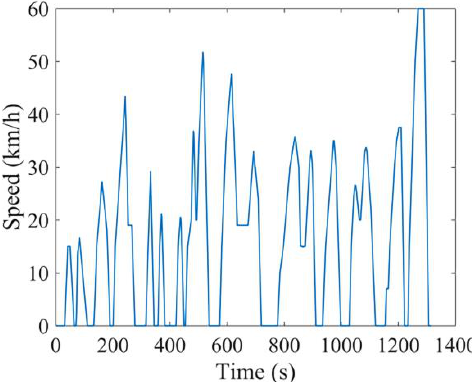
Figure 19. China Typica working condition.